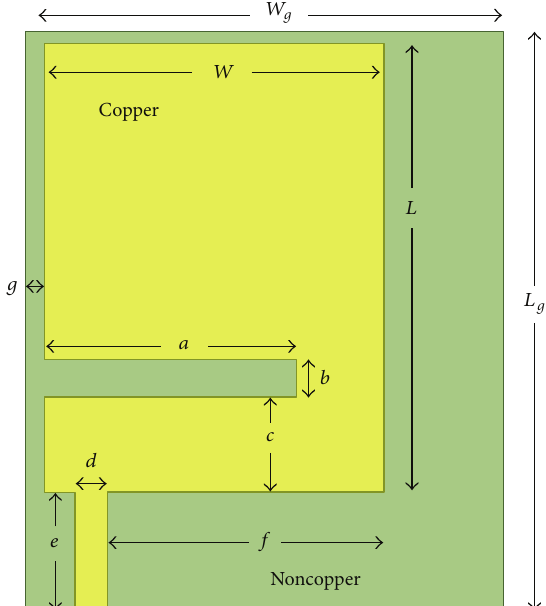
Figure 2: Design layout of the proposed antenna.